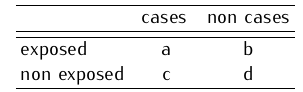
Table 2. Typical contingency